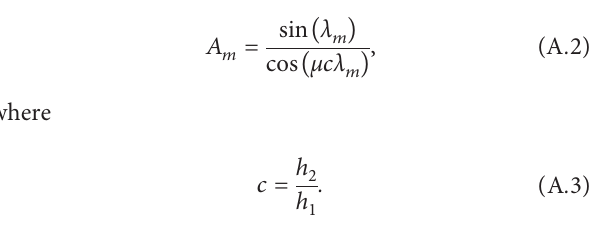
T v under different values of